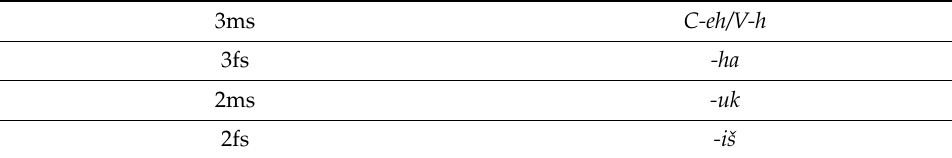
Table 7. Daf¯ar singular